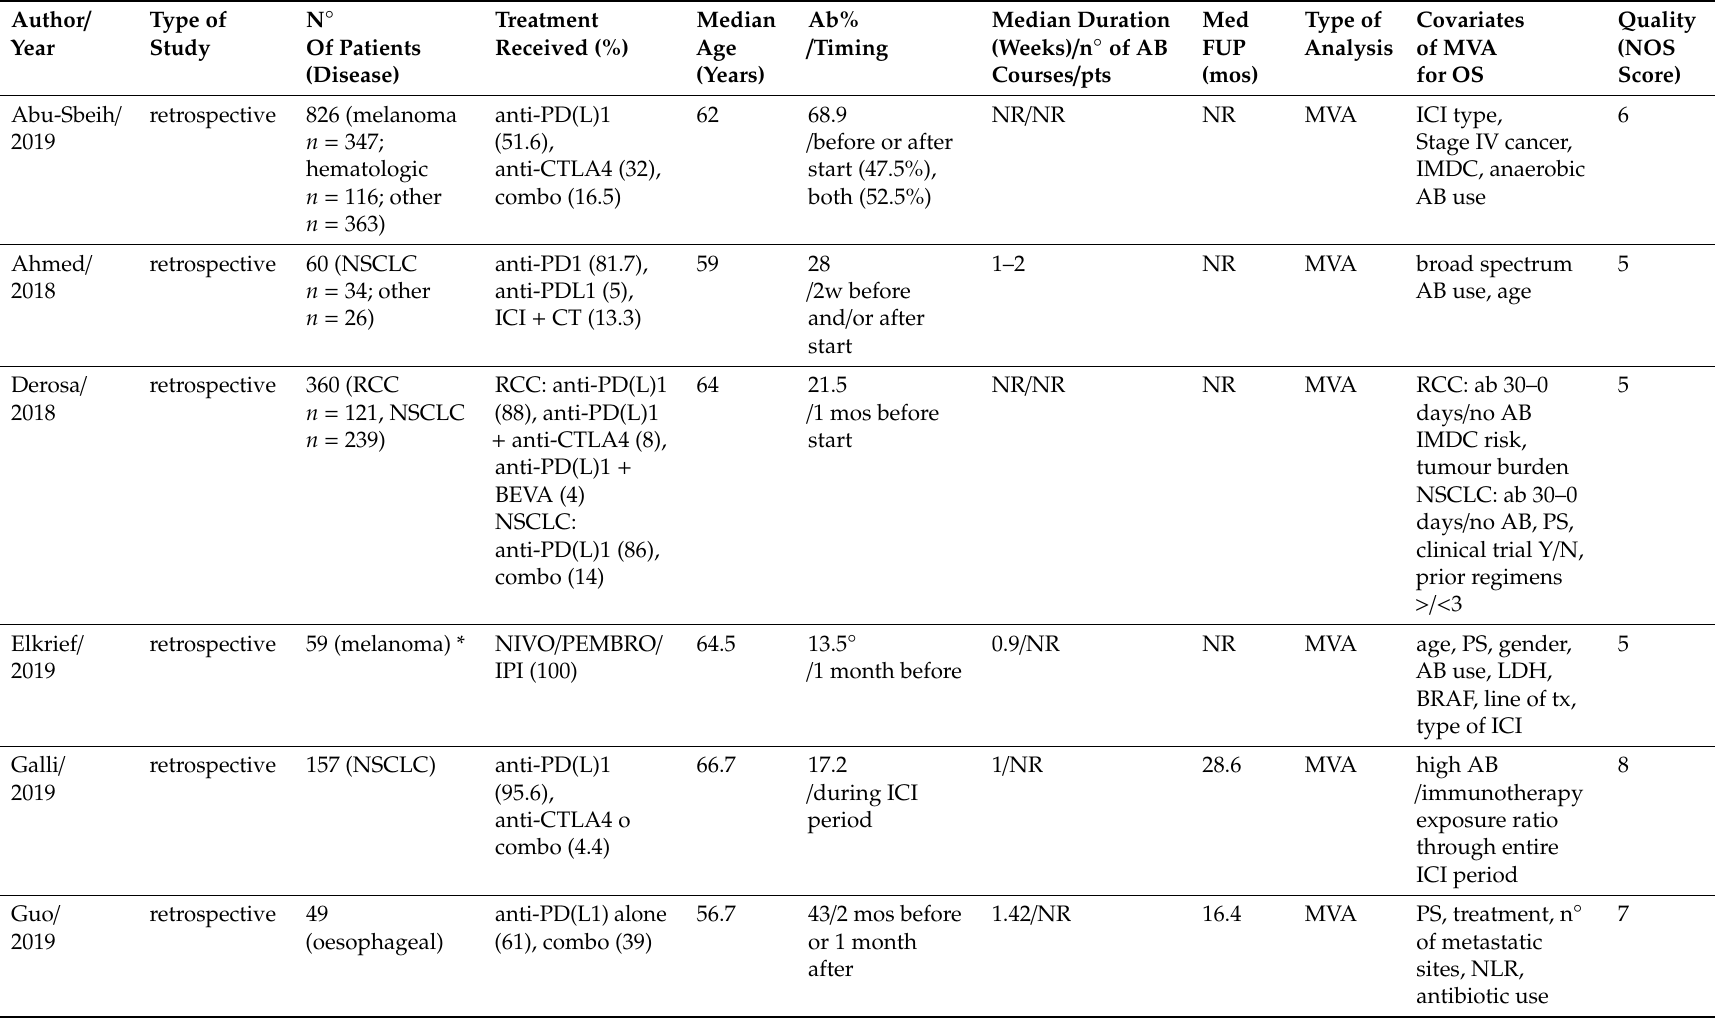
Table 1. Characteristics of included